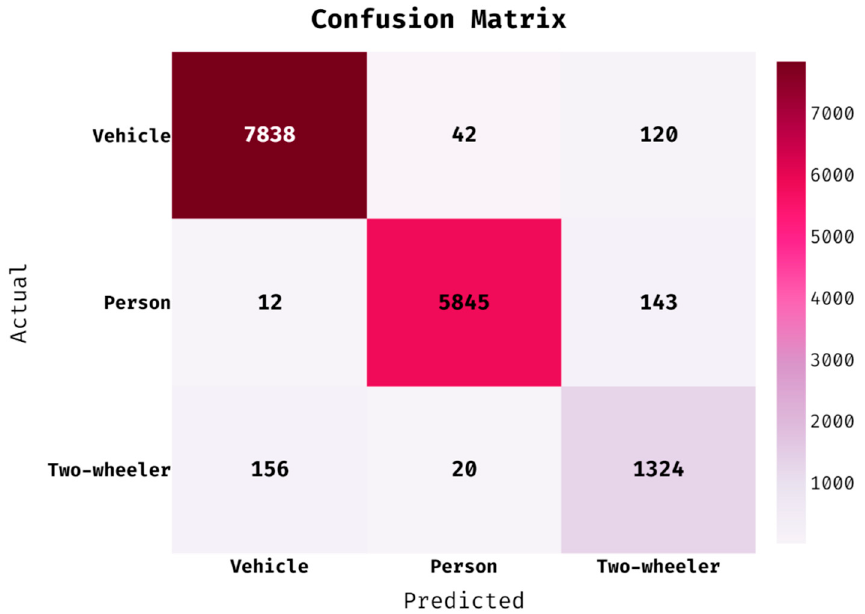
Figure 4. Confusion matrix of CIWHO-ORC technique on Bdd100k Dataset. Table 1. Manipulated values of confusion matrix by CIWHO-ORC